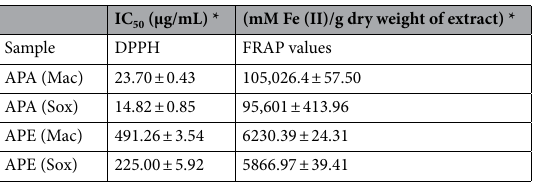
Table 1. IC 50 values obtained in DPPH assay and FRAP values. Values are means of three replicate samples (n = 3). Data are presented as the mean ± SD.